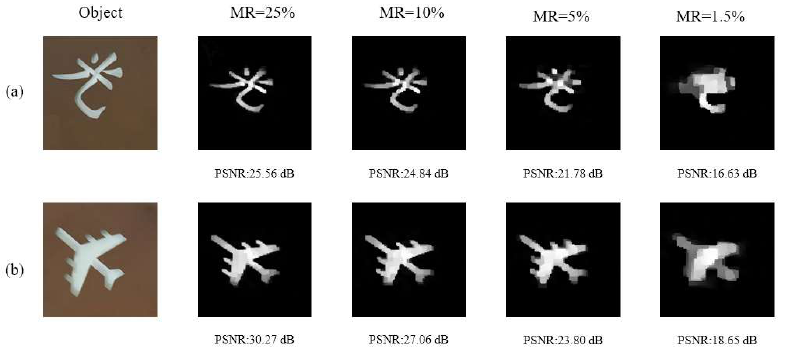
Figure 9. Single-pixel imaging results of other objects using SRMU-Net. ( a ) “light” pattern recon- struction results. ( b ) “airplane” pattern reconstruction results.